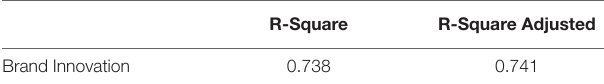
TABLE 3 | Predictive relevance of the model.